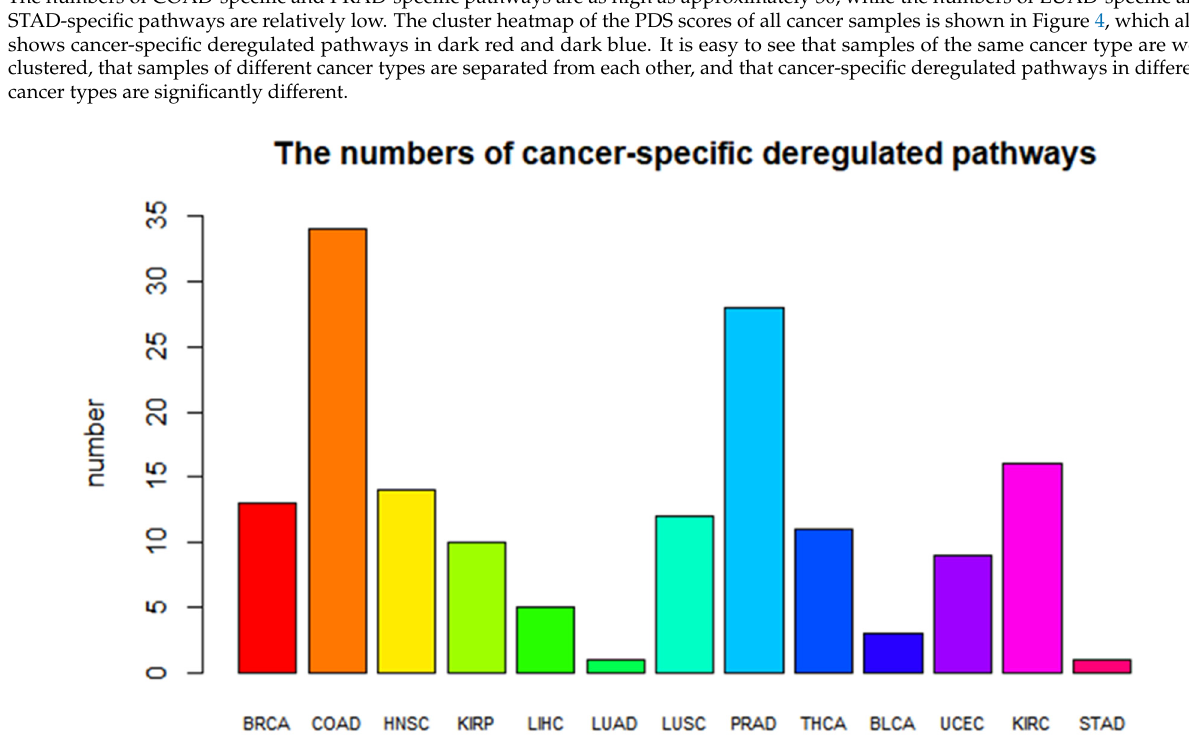
Figure 3. Barplot of the numbers of cancer-specific deregulated pathways. Different colors represent different types of cancer.